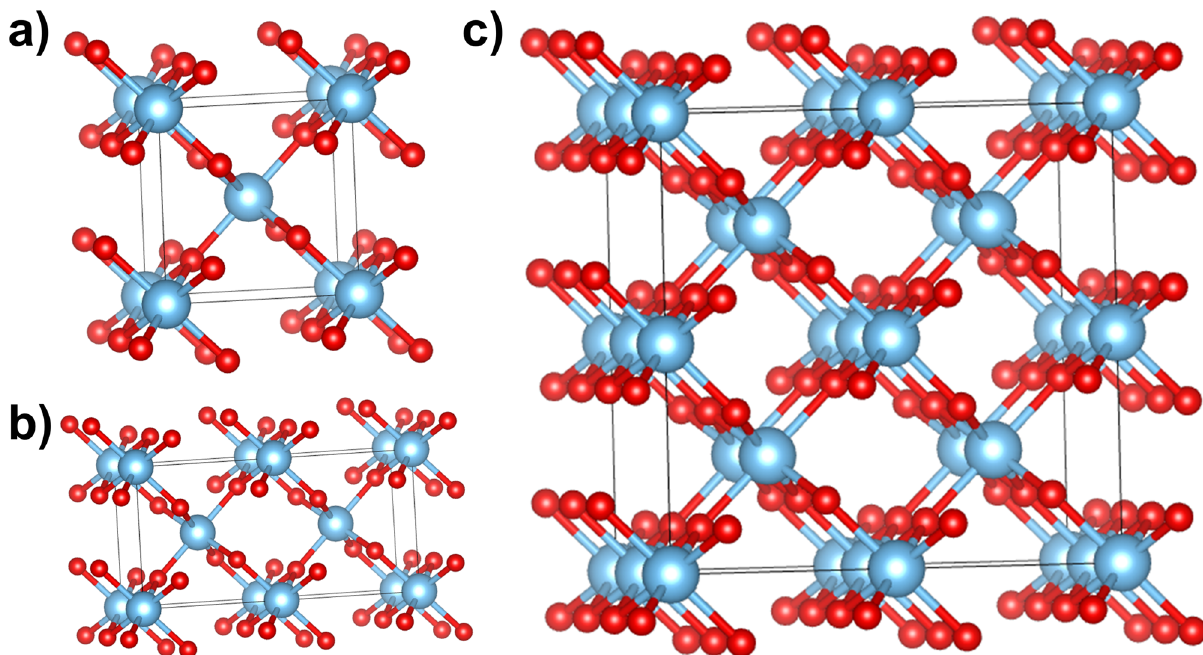
Fig. 6 Supercell transformation invariance. a Crystal cell of TiO 2 (mp-2657 111 ). b Crystal supercell of TiO 2 (mp-2657 112 ). c Crystal supercell of TiO 2 (mp- 2657 222 ).